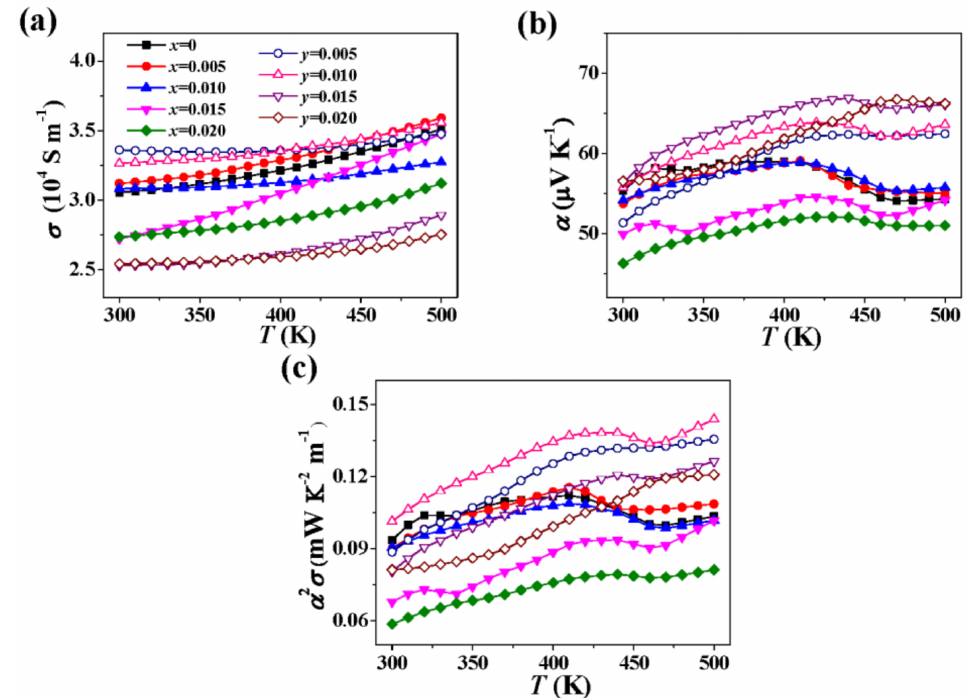
Figure 7. Temperature dependence of in-plane ( a ) electrical conductivity, ( b ) Seebeck coefficient, and ( c ) power factor of Cu-doped Cu x Bi 2 TeI and Zn-doped Zn y Bi 2